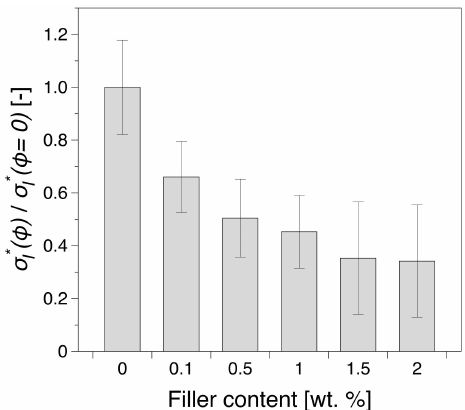
Figure 9. The relative impact strength, σ ∗